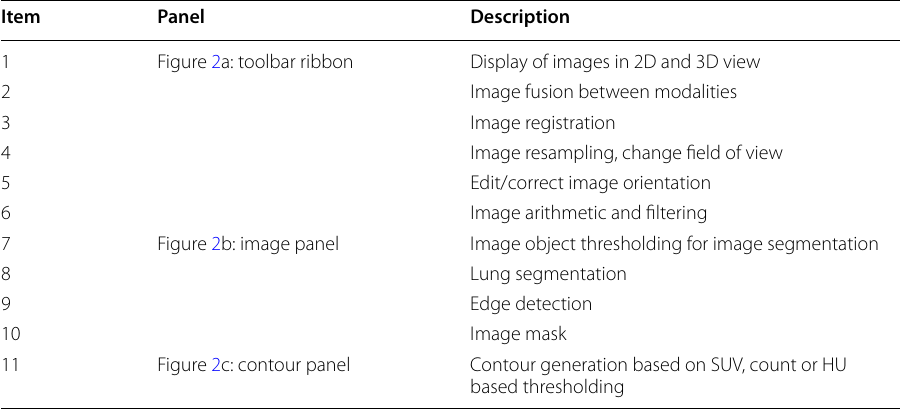
Table 2 The panel column indicates the ribbon or pull-down menu shown in Fig. 2